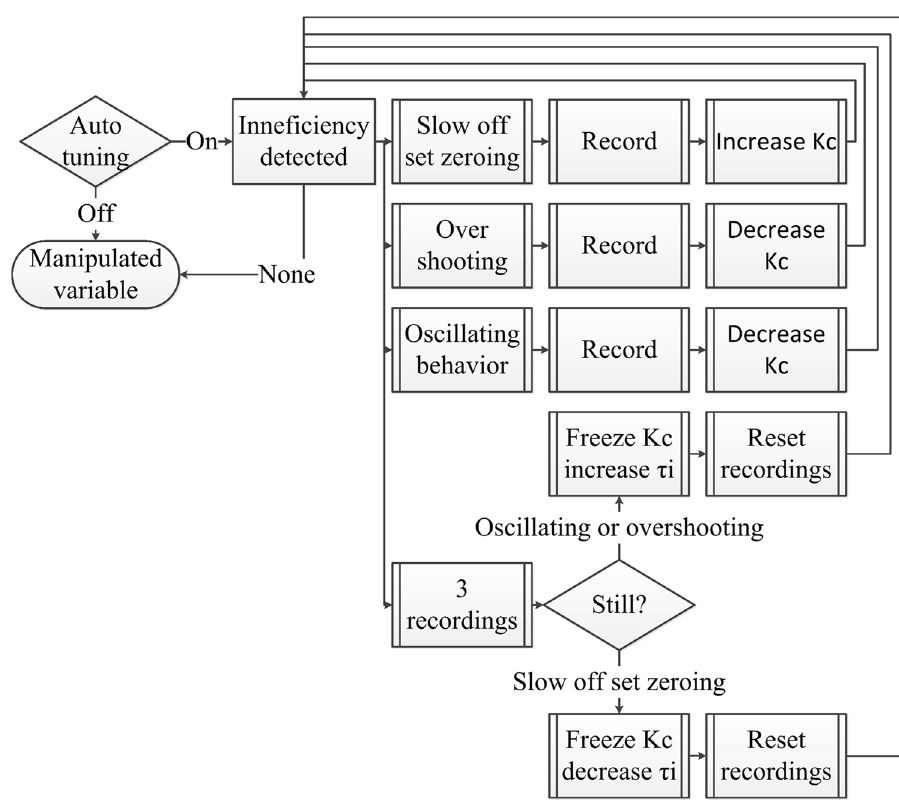
Fig. 3 Simplified schematic of the application